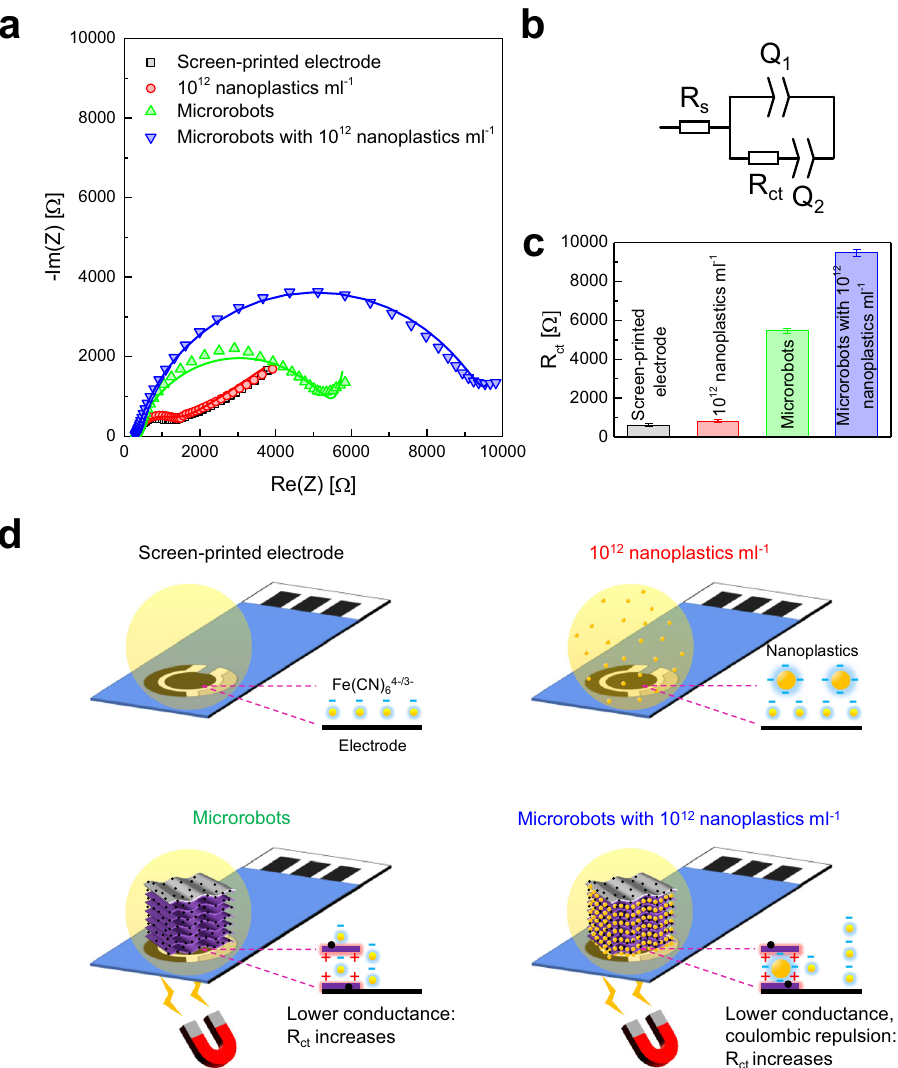
Fig. 7 Nanoplastics ’ detection by electrochemical impedance spectroscopy (EIS) technique after the preconcentration with the MXene-derived γ - Fe 2 O 3 /Pt/TiO 2 microrobots. a Nyquist plots showing the impedance real (Re(Z)) and imaginary (-Im(Z)) parts as a function of the frequency for a bare screen-printed electrode (SPE), an SPE exposed to ∼ 10 12 nanoplastics ml − 1 suspension, an SPE after MXene-derived γ -Fe 2 O 3 /Pt/TiO 2 microrobots ’ (thermal annealing condition: 0 min at 550 °C) loading, and an SPE after loading microrobots with captured nanoplastics (capture experiment conditions: 0.75 mg ml − 1 microrobots, ∼ 10 12 nanoplastics ml − 1 , water at pH 3, UV-light irradiation for 1 min, microrobots' collection using a neodymium magnet). The EIS measurements were performed in a 10 mM Fe(CN) 6 4 − /3 − aqueous solution at 0 V vs. ref. with a 10 mV superimposed sinusoidal root-mean-square voltage in the frequency range 10 5 ÷ 10 0 Hz. The lines represent fi ts to the data. b Equivalent circuit model for the Nyquist plots fi t: the electrolyte solution resistance (R s ) is in series with the double-layer capacitance of the working electrode described by a constant phase element (Q 1 ), which is in parallel with the charge transfer resistance at the electrolyte/electrode interface (R ct ) and a second constant phase element (Q 2 ). c R ct values obtained from the Nyquist plots fi t. Error bars represent the fi tting error. d Schemes of the different EIS measurements and electrolyte/electrode interfaces representing a bare SPE, an SPE exposed to a nanoplastics ’ suspension, an SPE where microrobots are loaded on the working electrode, and an SPE where microrobots with captured nanoplastics are loaded on the working electrode in a Fe(CN) 6 4 − /3 −